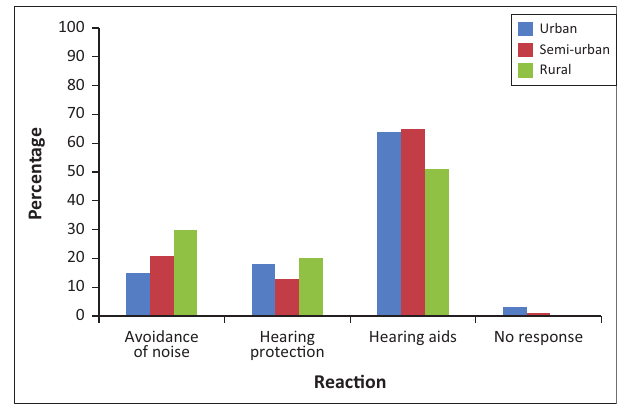
FIGURE 2: Management of noise-induced hearing